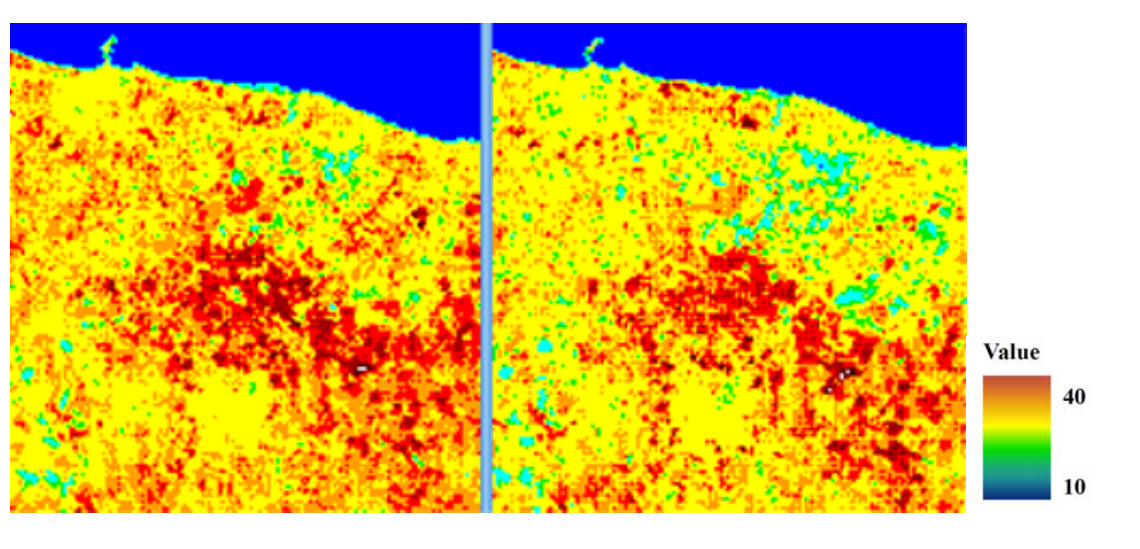
Figure 3. Spatial distribution of Land Surface Temperature (TS) in the subsets ASTER 2003 and 2007